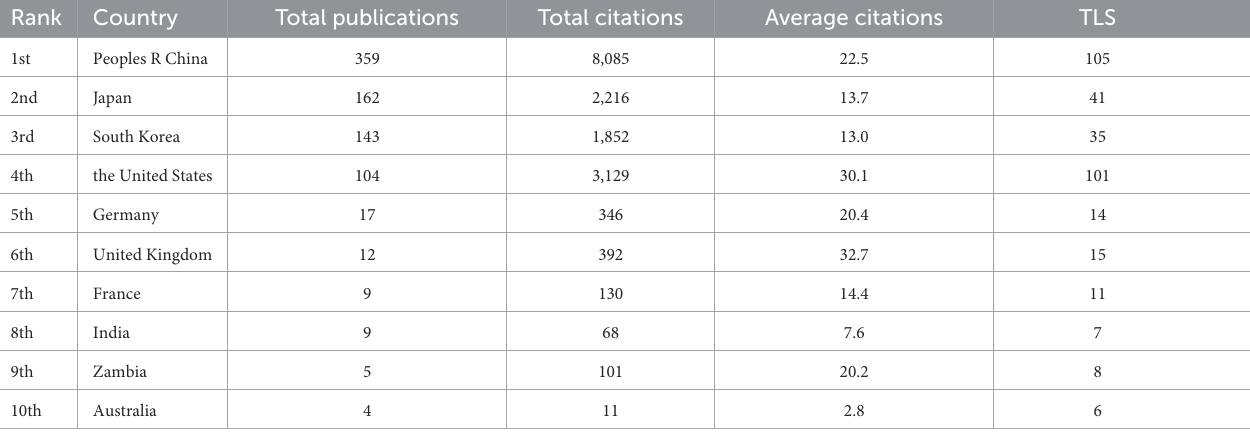
TABLE 1 The top 10 countries in number of publications concerning